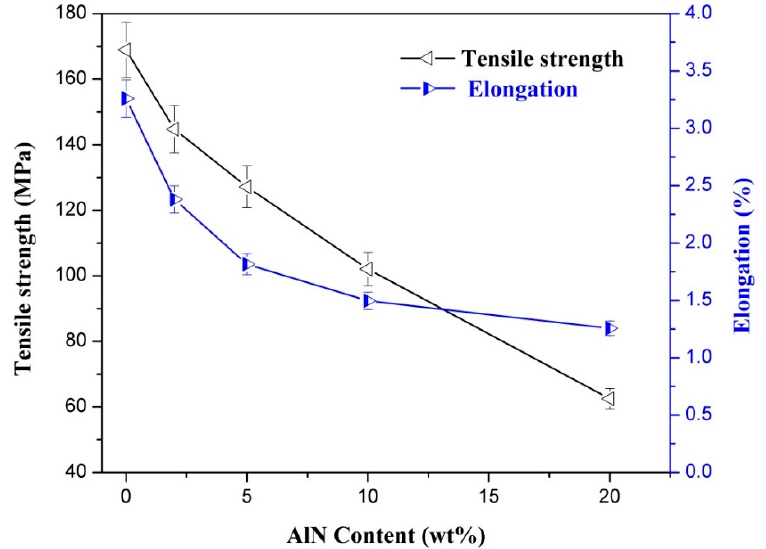
Figure 8. Mechanical properties of CNF-AlN composite reinforced with different amounts of AlN: (a) Tensile strength; (b) elongation.